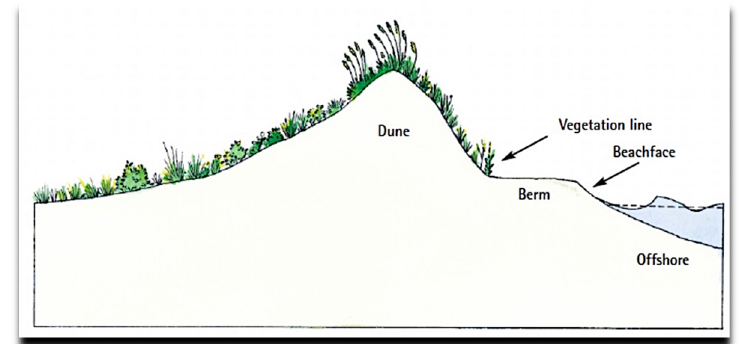
Figure 2. Schematic cross ‐ section of a typical beach–dune profile.